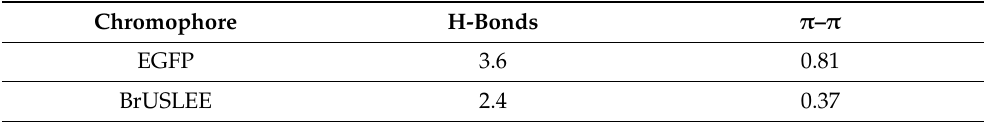
Table 3. Average number of protein–chromophore interactions per unit of MD time. Chromophore H-Bonds π – π